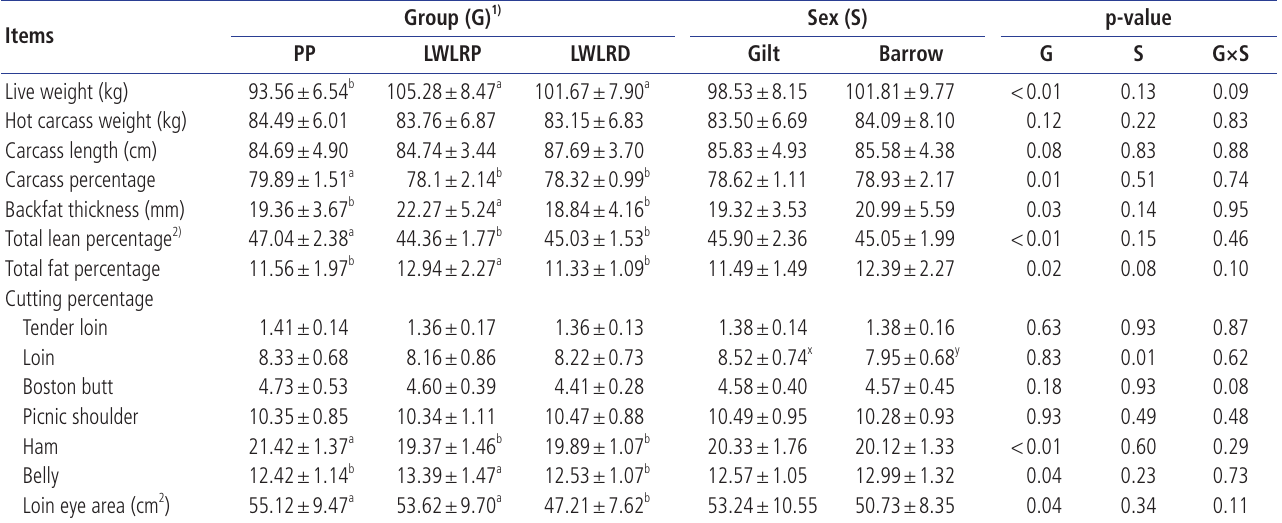
Table 2. Means±standard deviation of carcass traits of finished Pakchong 5 pig and crossbred pigs sired by Pakchong 5 or Duroc boar Items Live weight